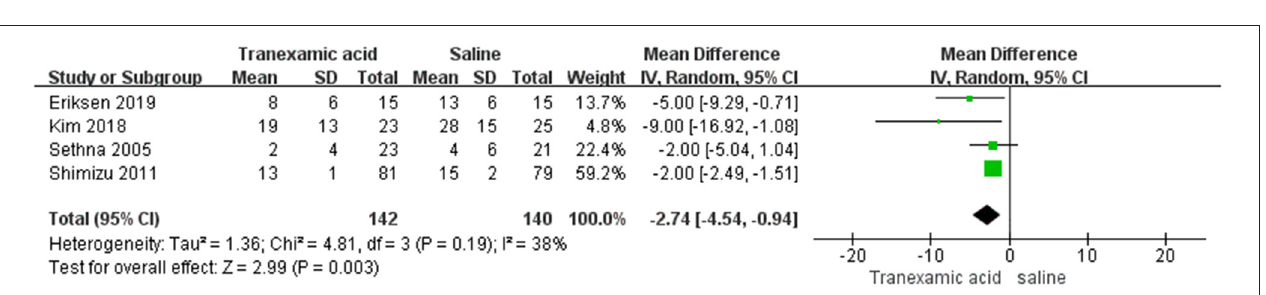
FIGURE 6 | Meta-analysis of RBC transfusion at 24h after surgery for TXA compared with placebo.